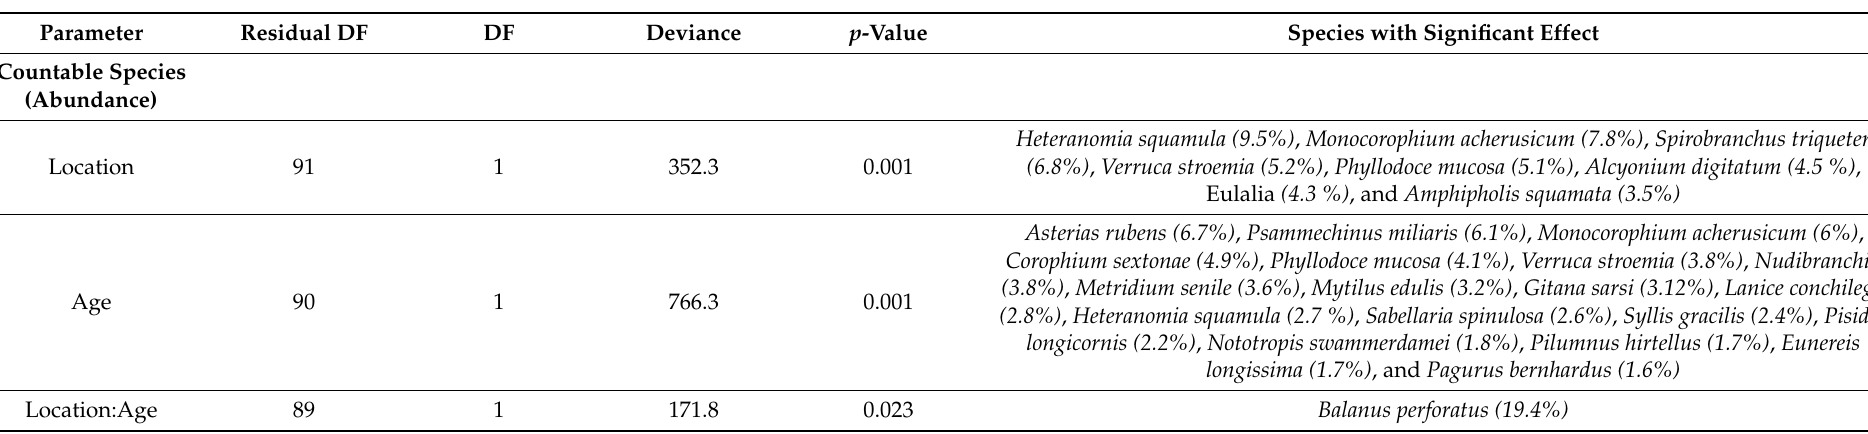
Table 2. Results of multivariate generalized linear models testing for the effects of location and age and their interaction on biofouling fauna community composition. Only those species with significant ( p < 0.05) parameter terms are listed and the contribution (%) to the parameter deviance is provided in